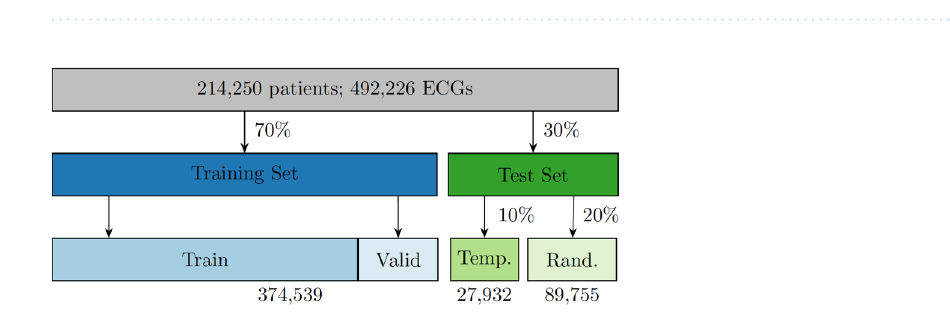
Figure 5. Data pre-processing of ECGs. From the raw input ECG we removed the baseline by filtering the tracing with a high-pass filter to remove biases and low-frequency trends. The filter is an elliptic filter with a cut-off frequency of 0.8 Hz and an attenuation of 40 dB, applied to the forward and reverse direction to obtain zero-phase distortion. We then resampled all ECGs to 400 Hz and zero-padded to a fixed length of 4096 samples, since the convolution-based model requires a fixed input size. For duplicated ECGs with identical data and collection time, the first copy was kept. ECGs where one or more required leads were missing or contained all-zero entries were removed. We used one-hot encoding for sex and normalized the age with the mean and standard deviation of the training dataset.